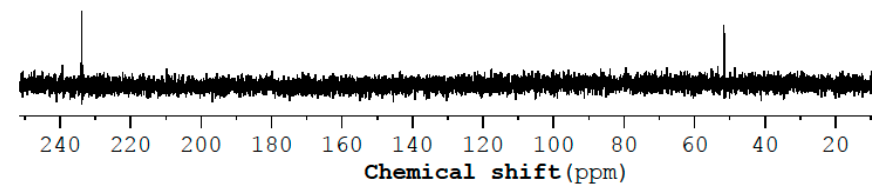
Figure 5. 15 N NMR spectra of the side [P3HT 0.6 -(P3HT-5F) 0.3 -P3HT-5F-N 3 ) 0.1 ], in CDCl 3 .